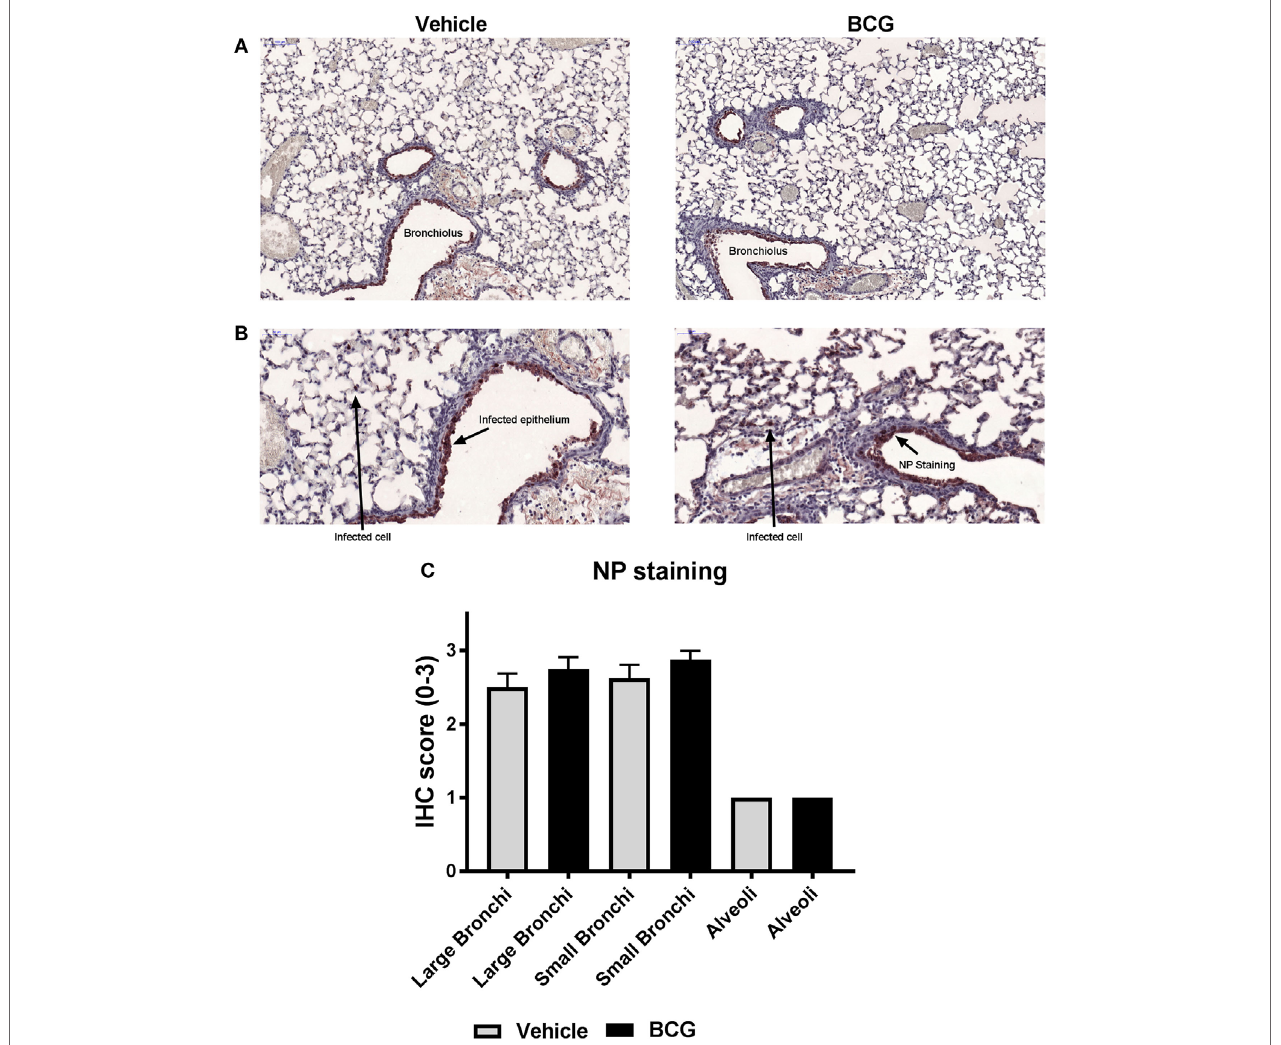
FigUre 6 | Nucleoprotein (NP) staining of bronchi and alveoli indicates that bacillus Calmette–Guérin (BCG) does not reduce influenza virus replication. Female BALB/c mice were challenged with a dose of 4MLD 50 influenza A/Anhui/1/2013 (H7N9) on day 0. Mice received 750 µg BCG or the vehicle control (phosphate buffered saline) i.v. on day –7 ( n = 8 per group). Three days after viral challenge, lungs were fixed in formalin. Paraffin-embedded tissue sections were then stained for influenza NP. Representative images of influenza A NP-stained lungs of mice treated with vehicle versus BCG-treated mice are depicted (a,B) . NP-staining was scored from absent to 3: score “0” (absent), score “1” (minimal), score “2” (moderate), and score “3” (marked) (c) . Results were statistically analyzed using the Cochran–Mantel–Haenszel test. Data are shown as mean ±